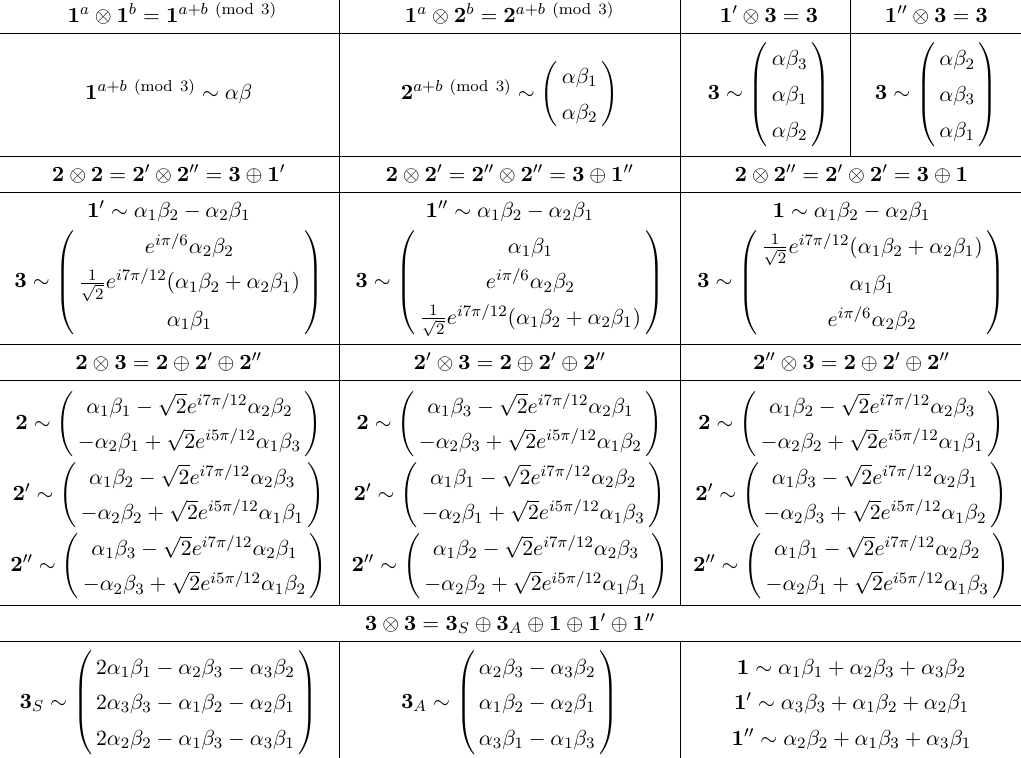
Table 4 . The Kronecker products and Clebsch-Gordan coe(cid:14)cients of the T 0 group. The tensor product of two irreducible representations R 1 and R 2 is reported in the form of R 1 (cid:10) R 2 . The elements of R 1 and R 2 are labeled as (cid:11) i and (cid:12) i